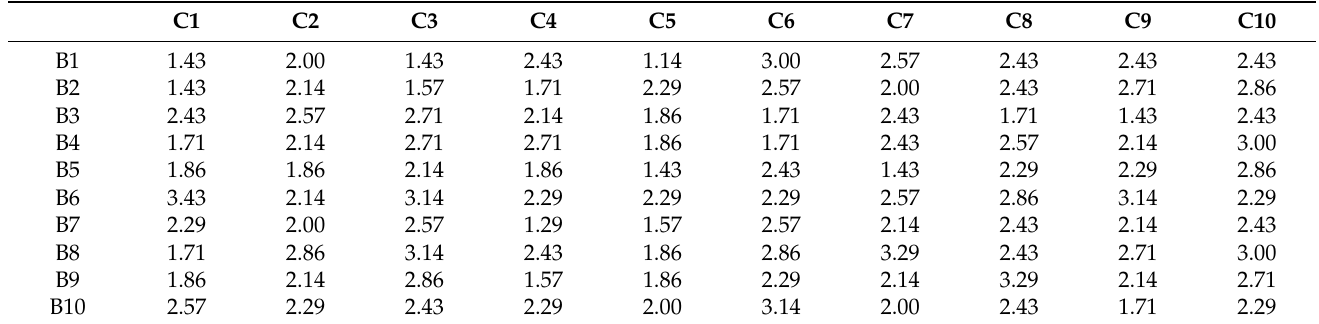
Table 15. Association matrix of resilience–big data analysis enablers. (B*C).